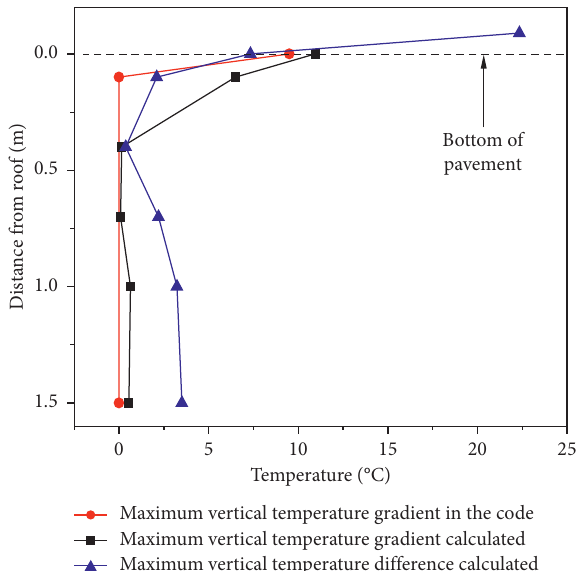
Figure 9: Comparisons of vertical temperature differences.